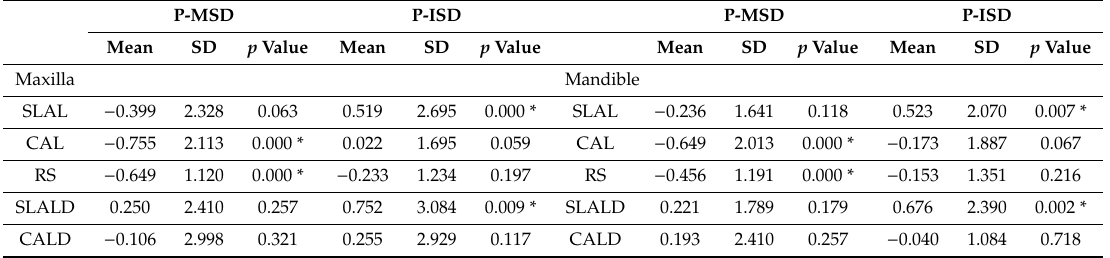
Table 2. Validity of arch length and arch length discrepancy measured by two methods. P-MSD P-ISD P-MSD